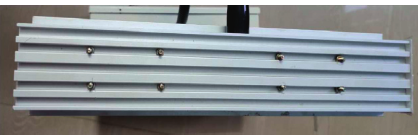
Figure 20: Profile of the LED system.